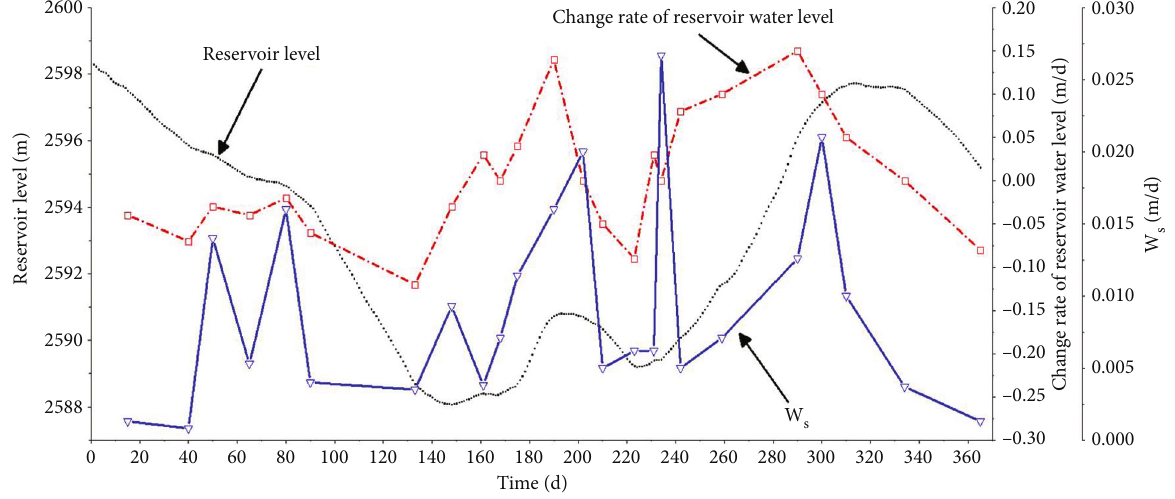
Figure 8: Calculation results of water level hysteresis coe ffi